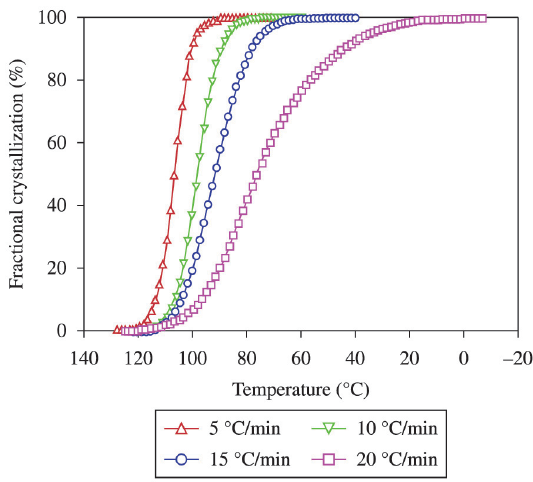
Figure 4. Typical crystallization plot (fractional crystallization vs temperature) for PHB/PS blend with 1% PS.